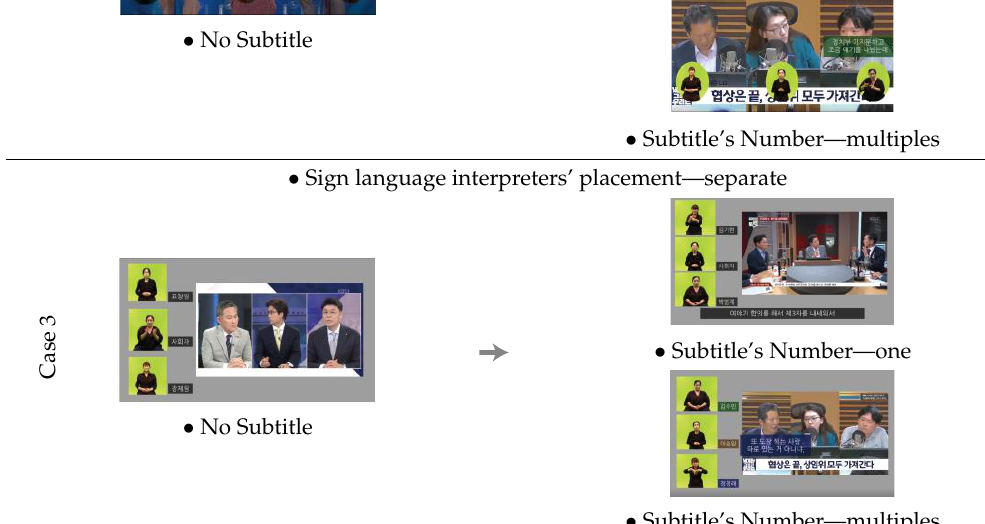
Table 2. Experiment design for news.